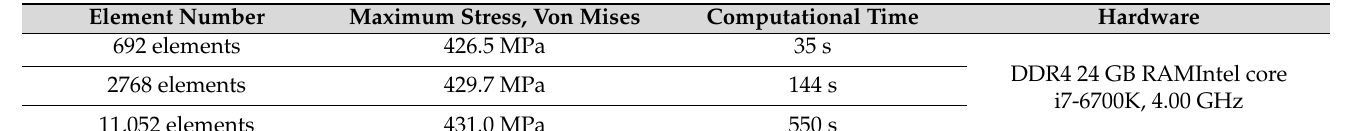
Figure 8. Stress comparison of the seat rear legs using three mesh cases. Table 9. Convergence study results.